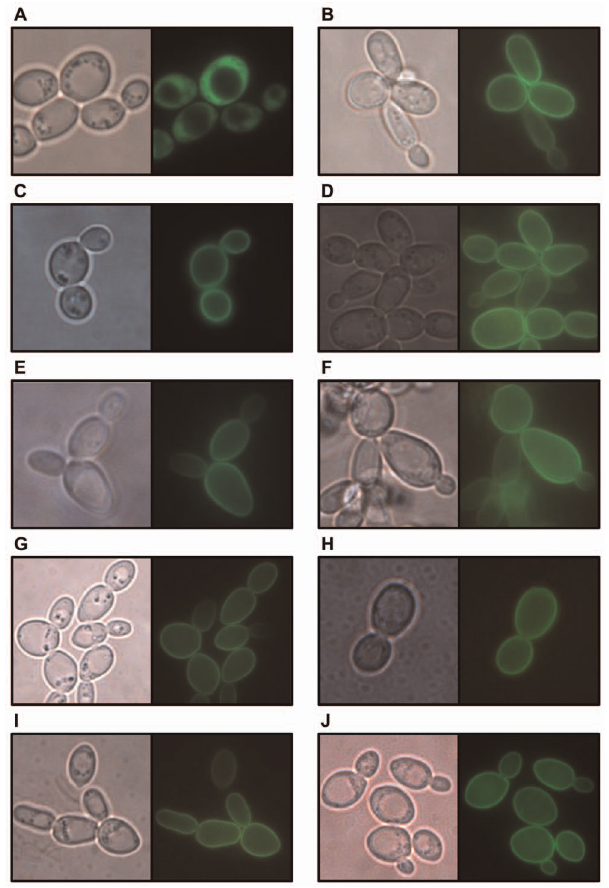
Figure 3. Localization of GFP-tagged D. hansenii putative transporters in S.cerevisiae plasma membrane. Phase contrast (left panels) and epifluorescence (right panels) images of S. cerevisiae YSH 1172 transformed with constructed centromeric plasmids (driven by the MET25 promoter). Strains MLY10 (A, empty plasmid), MLY7 (B), MLY8 (C), MLY9 (D), MLY12 (E), MLY20 (F), MLY22 (G), MLY23 (H), MLY25 (I), MLY26 (J), grown on YNB medium with 2% maltose.